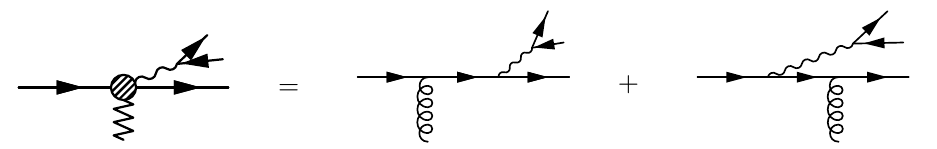
Figure 7. The j W current, eq. (2.23), is constructed from the two diagrams which contribute to the production of a W -boson from a given quark